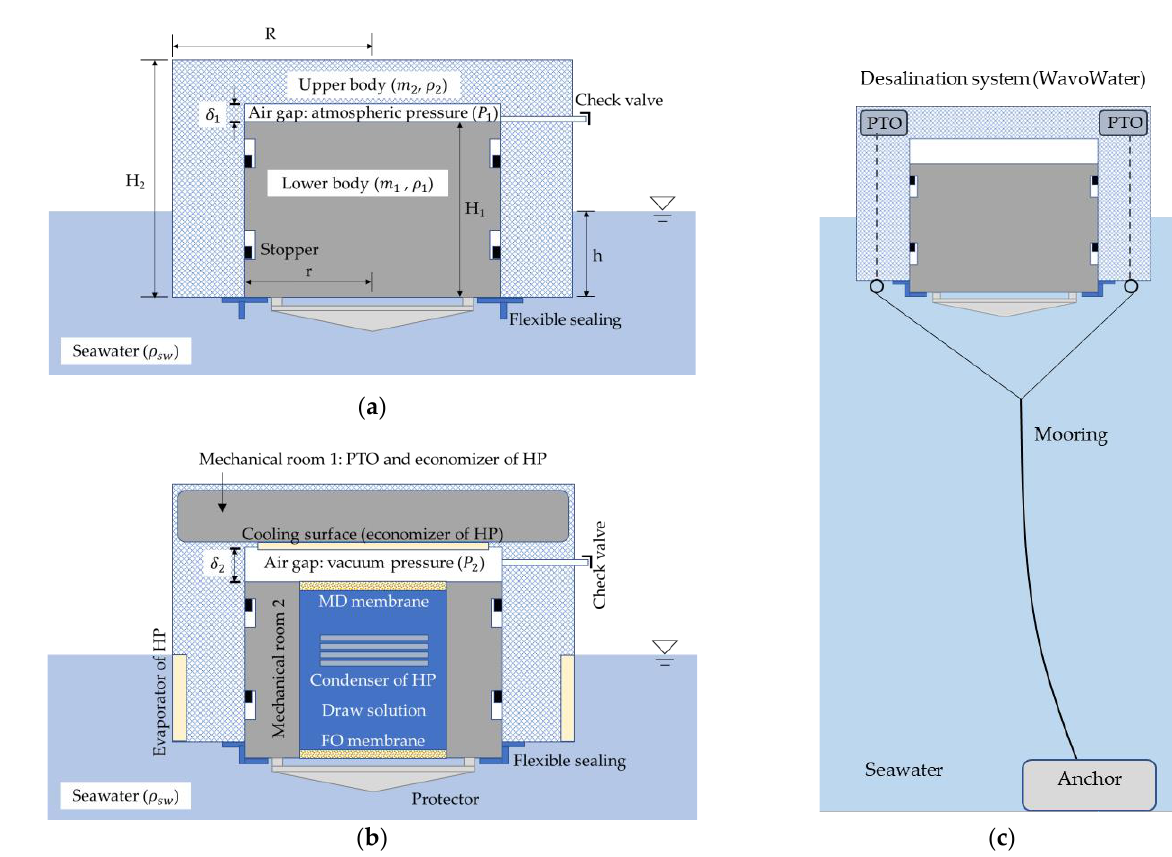
Figure 2. The concept of the wave-powered desalination system consisting of two different density bodies ( 𝜌 1 > 𝜌 2 ): ( a ) atmospheric pressure status of the air gap when the upper and the lower body are closest; ( b ) sub-atmospheric condition of the air gap due to the volume expansion caused of the density difference; ( c ) mooring system of WavoWater.